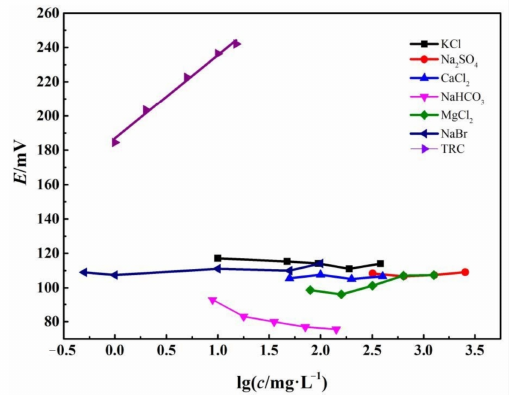
Figure 5. The OCP ( E ) of the Fc-CPE electrode in 3.5 wt.% NaCl containing possible interference ions with different concentrations.